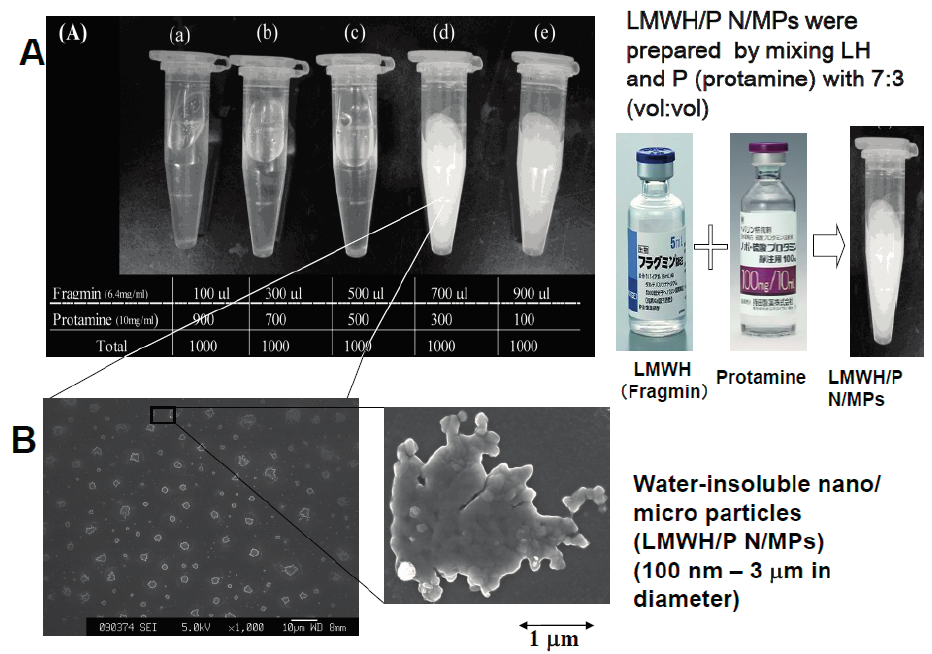
Figure 1. ( A ) Preparation and appearance of low molecular weight heparin/protamine nano/micro particles (LMWH/P N/MPs); ( B ) Electron microscopic appearance of generated LMWH/P N/MPs.